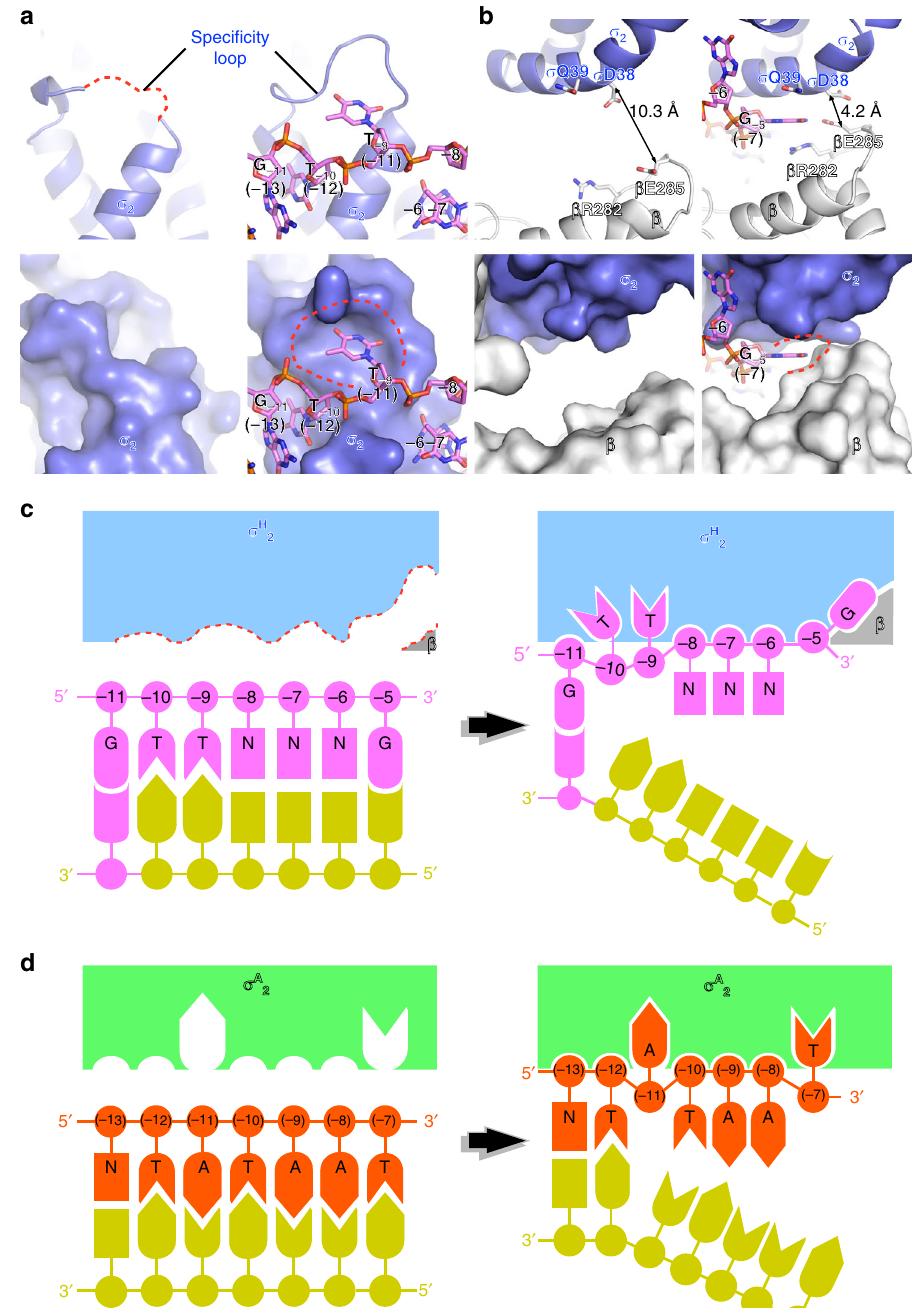
Fig. 6 The induced- fi t mechanism of promoter recognition by Mtb σ H -RNAP. a The T − 9 (nt) pocket does not exist in σ H -RNAP holoenzyme (left) but is induced by DNA binding in σ H -RPo (right) structures. b The G − 5 (nt) pocket does not exist in σ H -RNAP holoenzyme (left) but is induced by DNA binding in σ H -RPo (right) structures. The pockets are presented in cartoon (top) and surface (bottom). c The schematic of induce- fi t model of promoter recognition by σ H -RNAP. d The schematic of lock-and-key model of promoter recognition by σ A The derivatives of pARTaq-N25 – 100-TR2 for in vitro transcription assays of Mtb σ A with varied − 35/ − 10 spacer lengths were obtained by site-directed mutagenesis (Supplementary Figure 2K). Protein preparation . For preparation of M. tuberculosis σ H , E. coli BL21(DE3) cells (NovoProtein) carrying pTolo-EX5- Mtb σ H were cultured in Luria-Bertani broth (LB) at 37°C, and the expression of N-terminal sumo-tagged Mtb σ H was induced at 18 °C for 14h with 0.5mM isopropyl β - D -1-thiogalactopyranoside (IPTG) at OD 600 of 0.8. Cells were harvested by centrifugation (8000× g , 4°C), re-